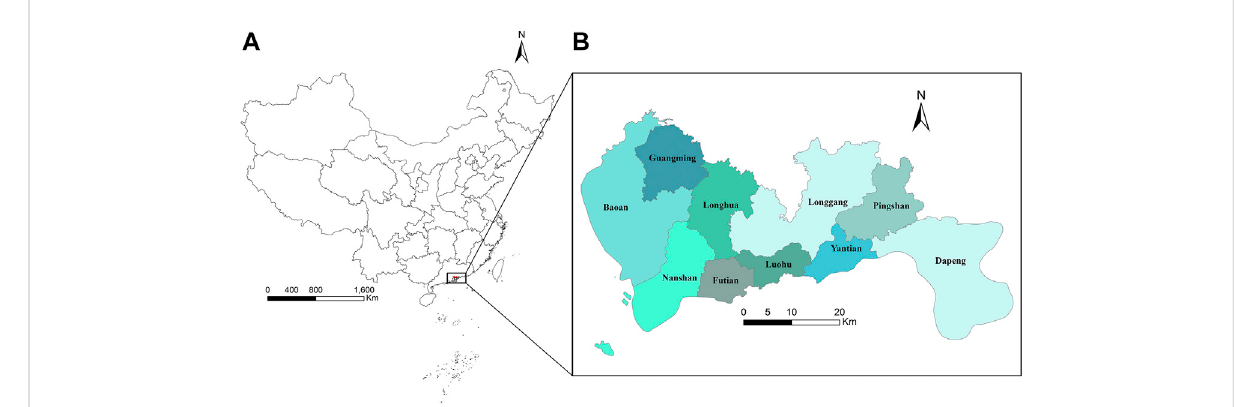
FIGURE 1 The location of Shenzhen in China (A) and its county subdivision (B) .